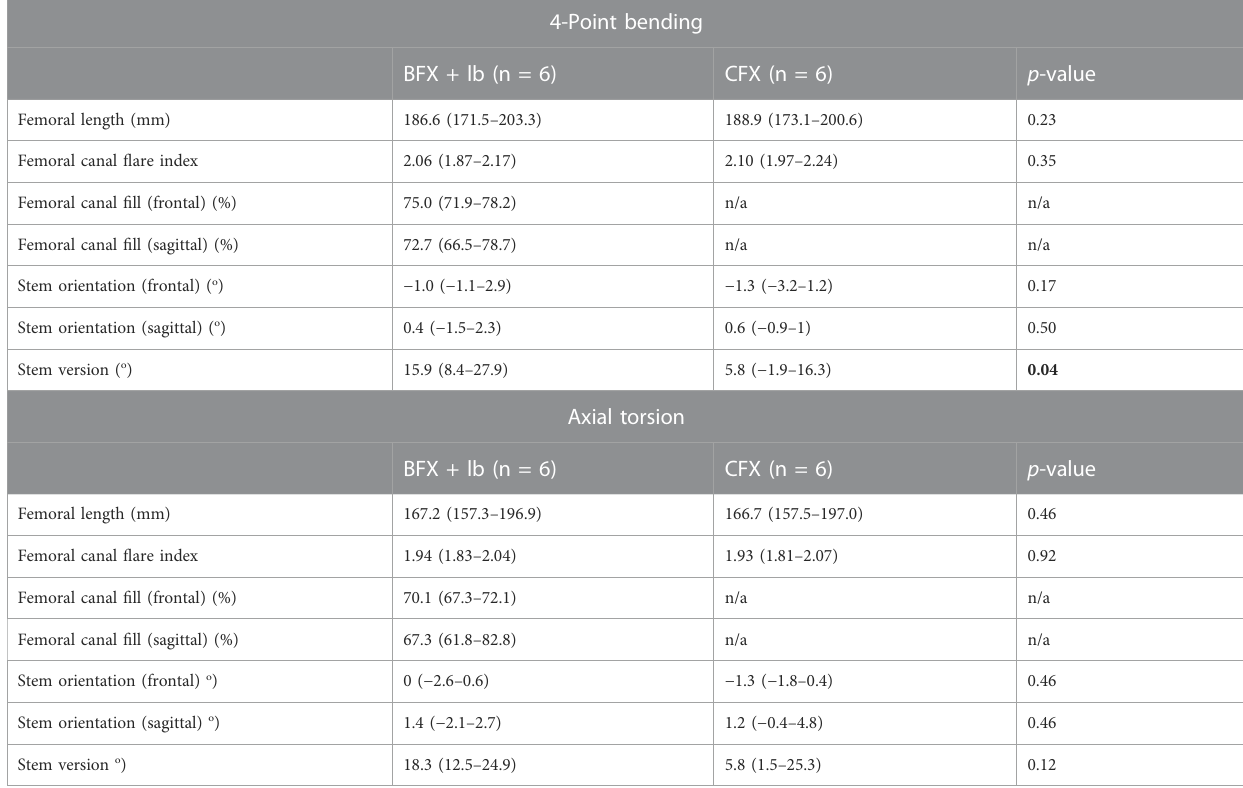
TABLE 2 Femoral length and canal fl are index, and radiographic analysis of THR implantation in femora tested in 4-point bending (top) and in axial torsion (bottom).Reportedvaluesaremedian(range).Apositivestemorientationinthefrontalplaneindicatesstemvarus,apositivestemorientationinthesagittalplan indicates cranial tipping, and a positive version indicates anteversion. Femoral length and canal fl are index were compared using a related-samples Wilcoxon signedranktest.AllothermeasurementswerecomparedusingaWilcoxonsignedranktest. p < 0.05wasconsideredstatisticallysigni fi cant.Cementedstemswere placed in less anteversion than BFX + lb stems for the group tested in 4-point bending.